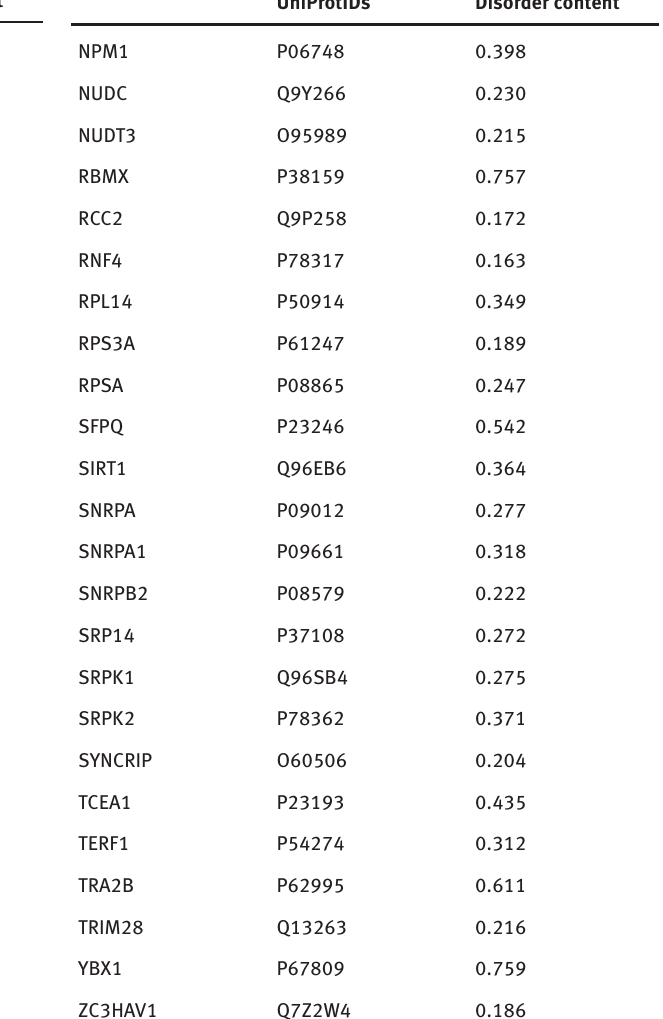
Table 1: List of the 49 APE1 interactors likely to undergo phase separation. These 49 interactors were identified by comparing the APE1 PPI network to the LLPS-oriented databases PhaSepDB and PhaSePro and characterized by an internal disorder content index (as computed by MobiDB) greater or equal to 0.15. Their UniProtID and the internal disorder content index are